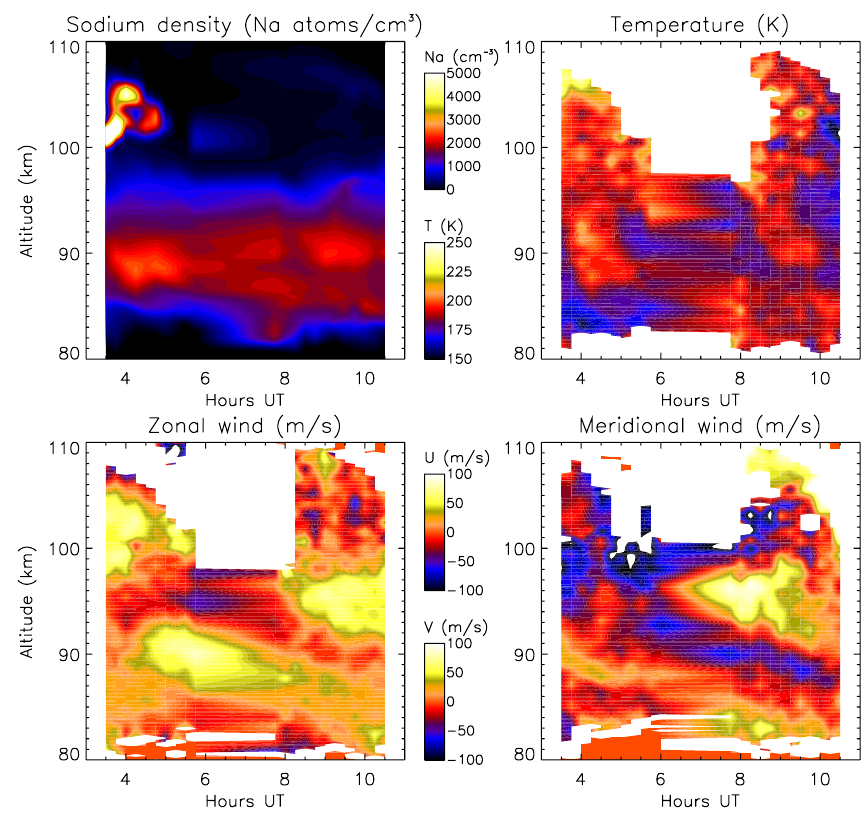
Fig. 4. Contour plots of density, temperature, and zonal and meridional winds with 15min and 1km resolution.